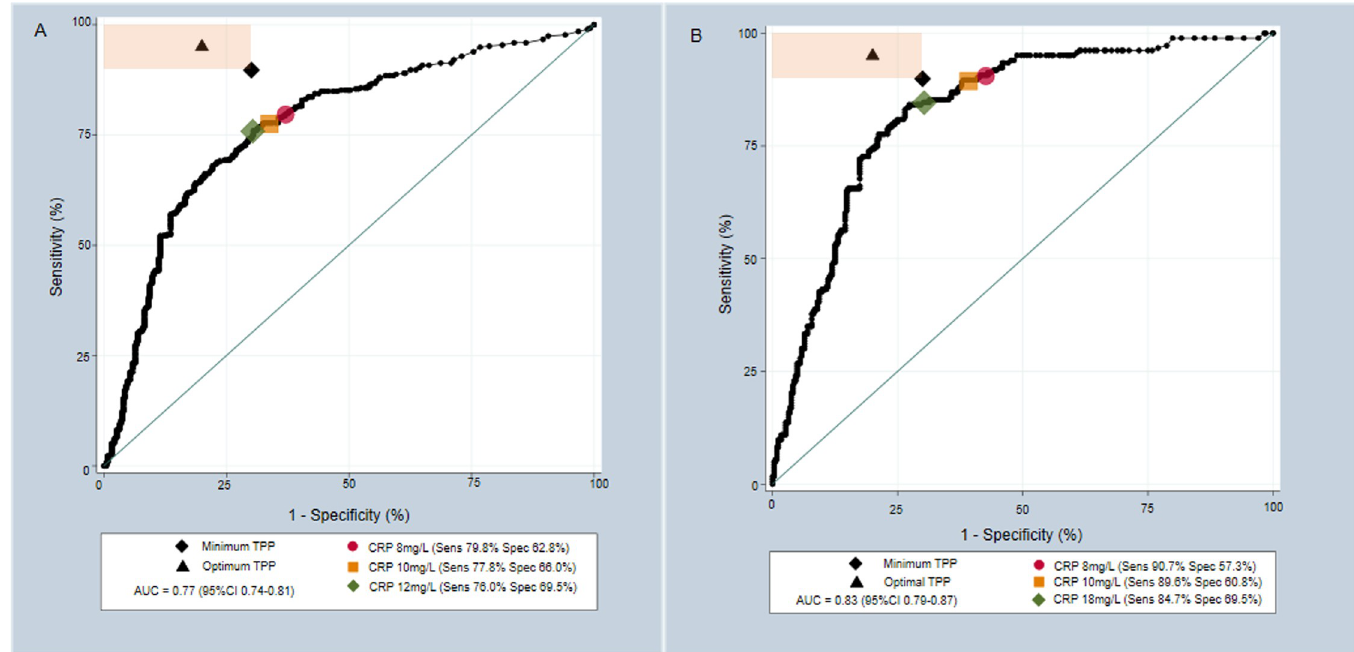
Fig 2. Receiver Operating Characteristic (ROC) curves demonstrating the performance of CRP in the diagnosis of PTB. A) ROC curve against culture; B) ROC curve against Xpert MTB/Rif. The shaded orange area represents the sensitivity and specificity combinations that meet at least the minimum target of one of the Target Product Profile characteristics. Minimum (Sensitivity 90% Specificity 70%) and Optimal (Sensitivity 95% Specificity 80%) Target Product Profile targets are plotted. Pre-defined CRP cutoff-points are plotted as red circles and yellow squares with optimal CRP cutoff-points plotted as green diamonds; all have estimated performance stated. AUC = Area Under Curve; TPP = Target Product Profile; PTB = Pulmonary tuberculosis.